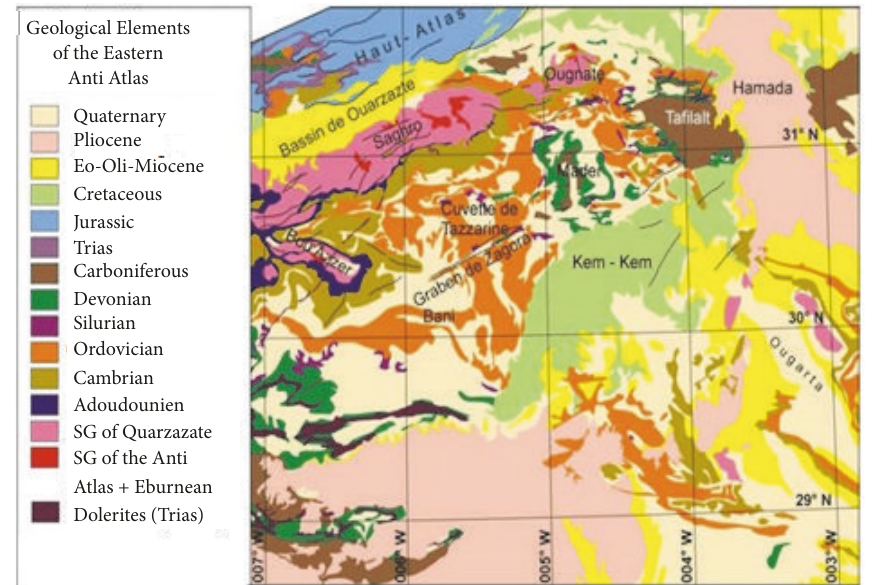
Figure 1: Geological elements of the Anti-Atlas of the East. According to the geological map 1/1,000,000 of Morocco